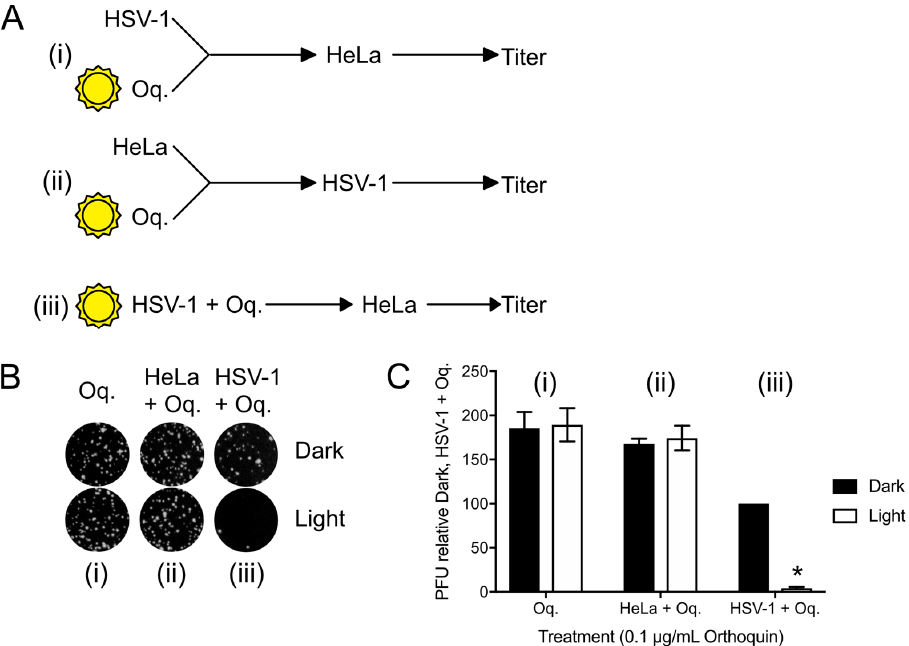
Figure 6. Orthoquin anti-HSV-1 activity depends on close proximity with virions during the photoactivation step. ( A ) Experimental schema for Orthoquin treatments: (i) Orthoquin was exposed to light in clear or dark tubes for 10 min and was then combined with HSV-1 virions and used to infect HeLa cells; (ii) Orthoquin was exposed to light in clear or dark tubes then used to treat a monolayer of HeLa cells for 1 h. Afterwards, the cells were infected with HSV-1; (iii) Orthoquin PDI of virions prior to infection as in Figures 3 and 4. ( B ) Representative plaque assays are shown for the three experimental schema. ( C ) Plaque assay data from three independent experiments were quantified. Values were normalized to the number of plaques detected to the combined Orthoquin/HSV-1 treatment in the dark tubes (schema iii). n = 3 ± SEM from three independent biological replicates. * = p < 0.05 by two-way ANOVA. Oq = Orthoquin.